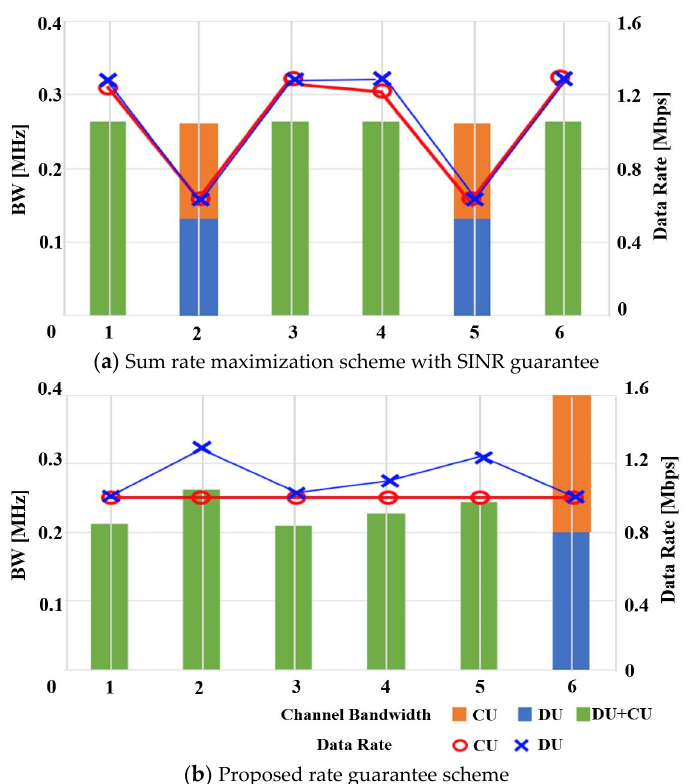
Figure 3. Snapshots of channel bandwidths and data rates for six sample points matches.